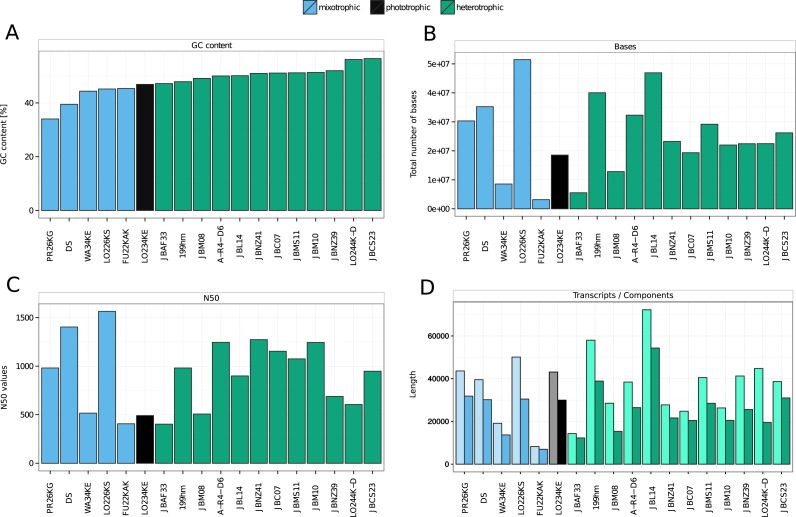
Statistics for transcriptomes assembled with Trinity.(A) shows the GC content of each strain. Since the GC content separates the trophic modes, the other panels were also sorted by GC content. (B) shows the estimated transcriptome sizes (total number of bases in transcriptome). (C) shows N50 value of each strain (contig length such that half of the transcriptome is in contigs longer than this length). (D) shows the number of assembled transcripts (light colour) and components (approximately genes; dark colour) for each sample.